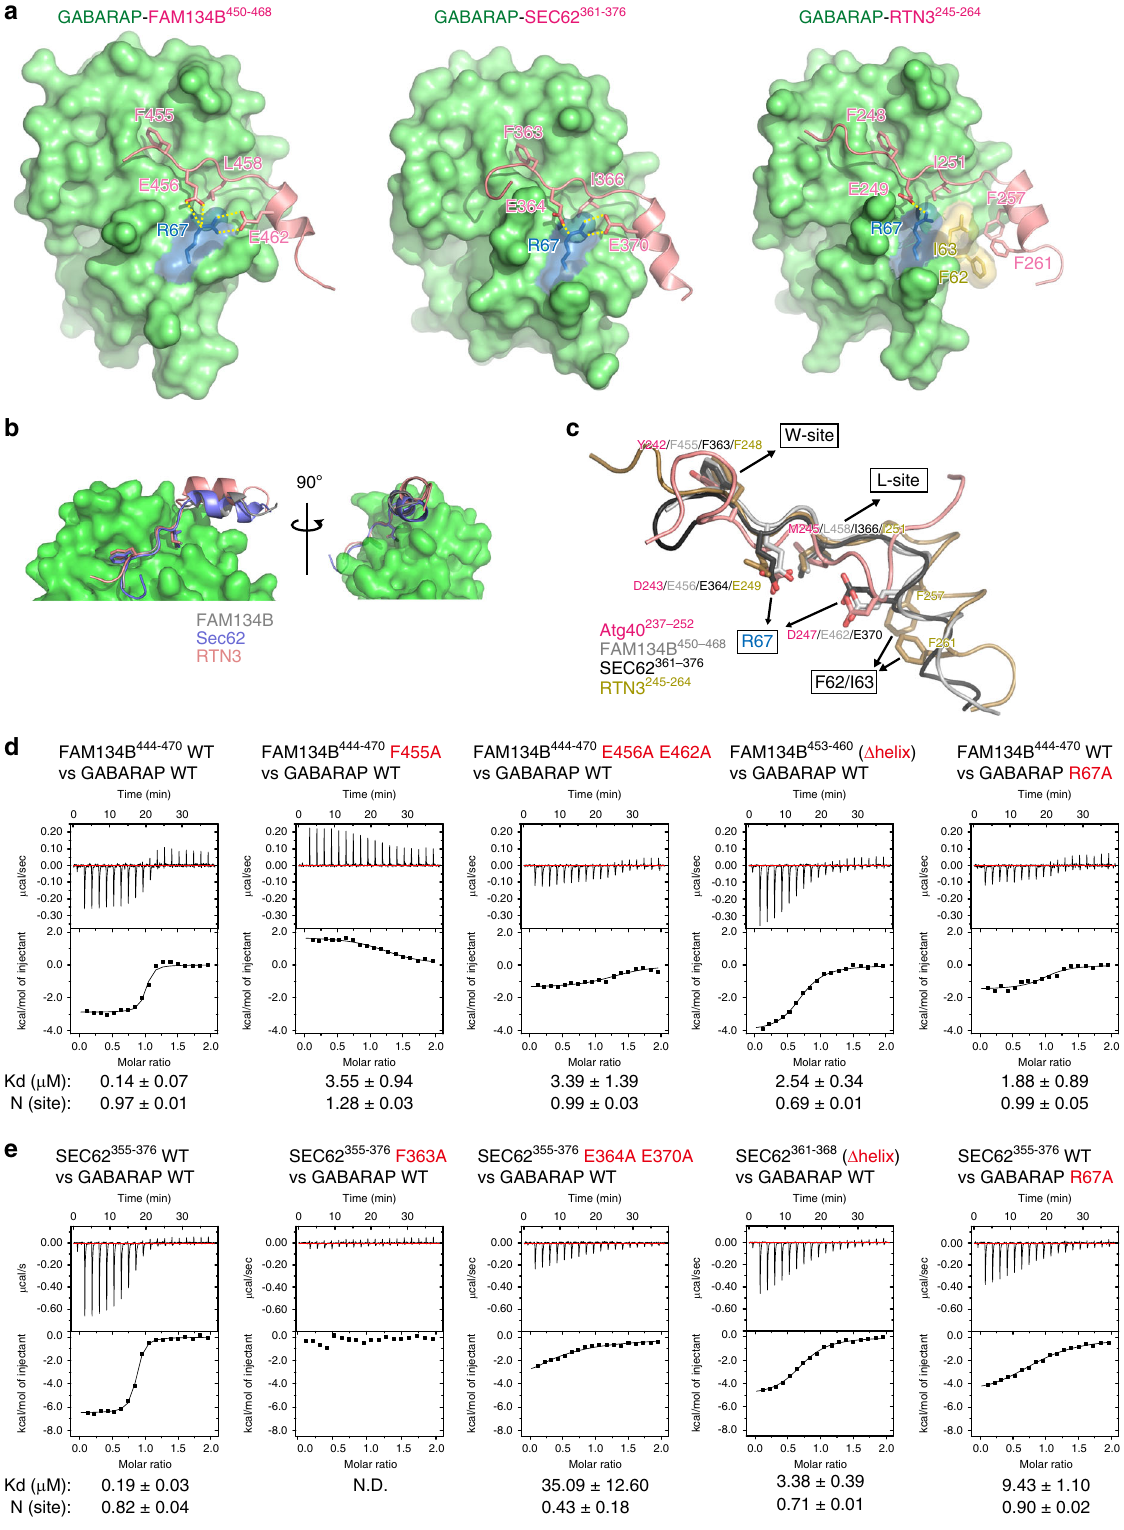
Fig. 6 Evolutionary conserved helices C-terminal to the AIM/LIR enhance interactions between ER-phagy receptors and Atg8-family proteins. a , b Crystal structures of GABARAP-FAM134B 450 – 468 , GABARAP-SEC62 361 – 376 , and RTN3 245 – 264 . Green and pink indicate GABARAP and ER-phagy receptor AIMs, respectively. c Superimposition of Atg8/GABARAP-binding regions of ER-phagy receptors based on the structures of Atg8 and GABARAP. d , e Binding af fi nity of FAM134B ( d ) and SEC62 ( e ) peptides to GABARAP was measured by